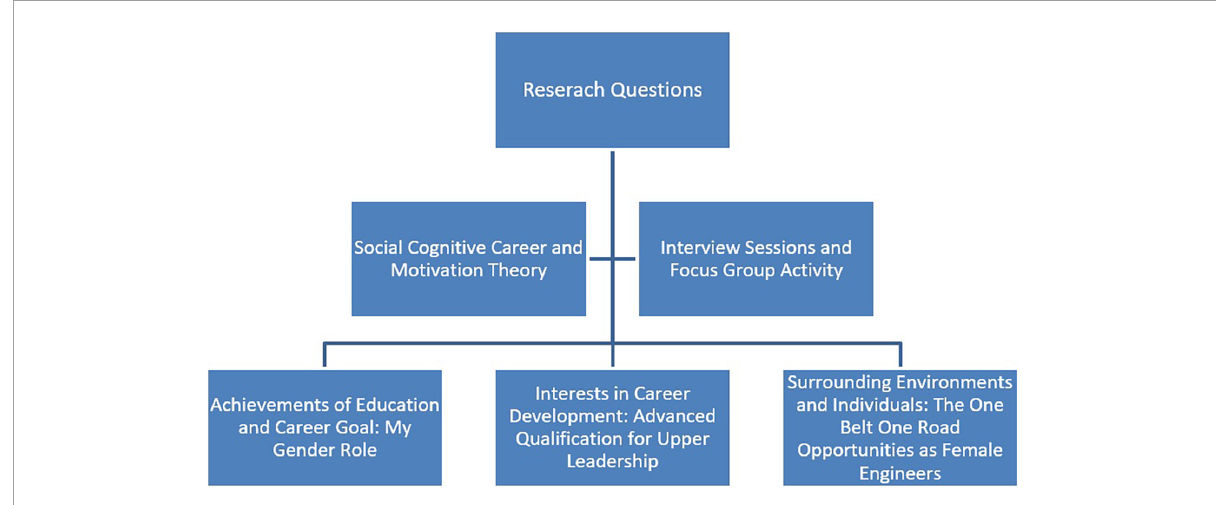
FIGURE2 Relationship between the research questions, theoretical framework, data collection tools, and finding